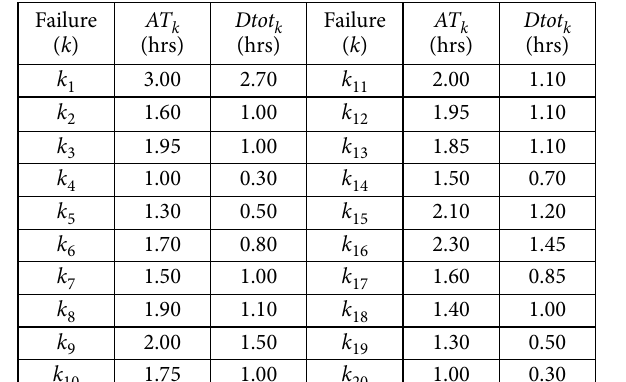
Table 4. Repair assignment matrix in the idle